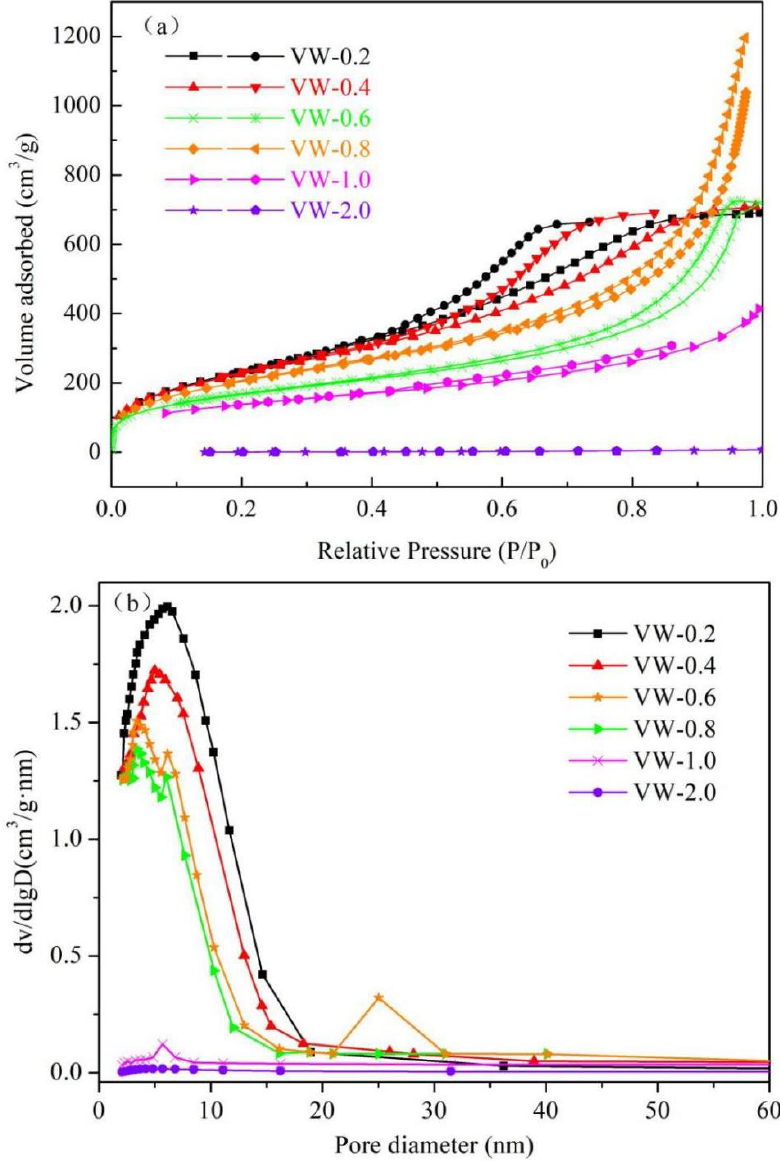
Figure 5. For the different samples; ( a ) nitrogen adsorption/desorption isotherms, and ( b ) pore diameter distribution curves.